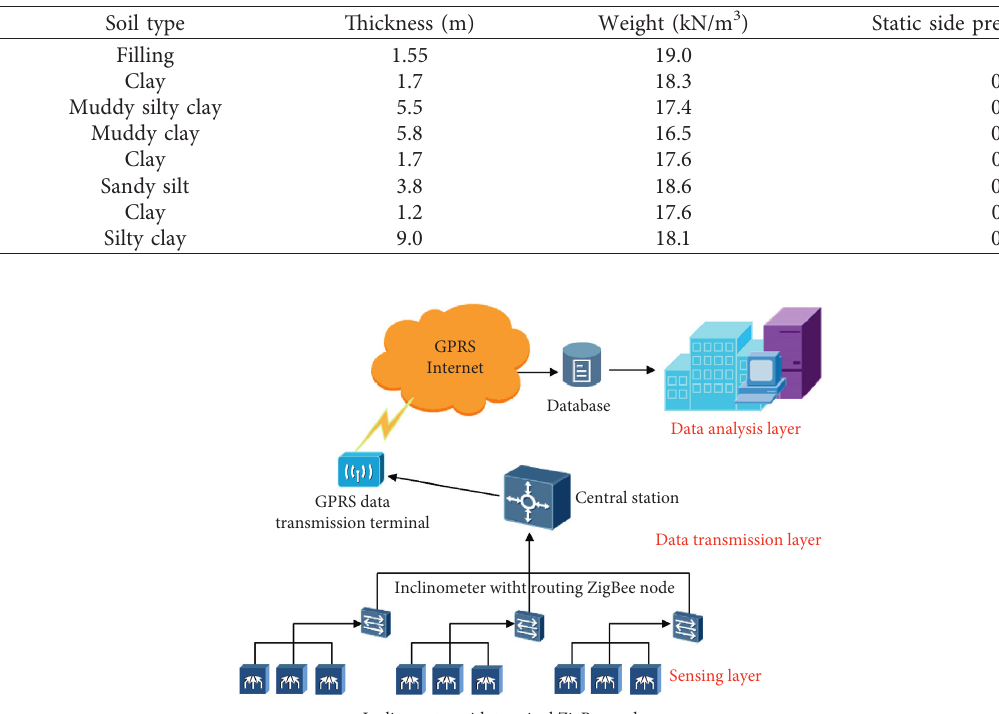
Figure 11: Section diagram between the pit and Shanghai Metro Line 13 (all distances are in m). Table 2: Soil characteristics.